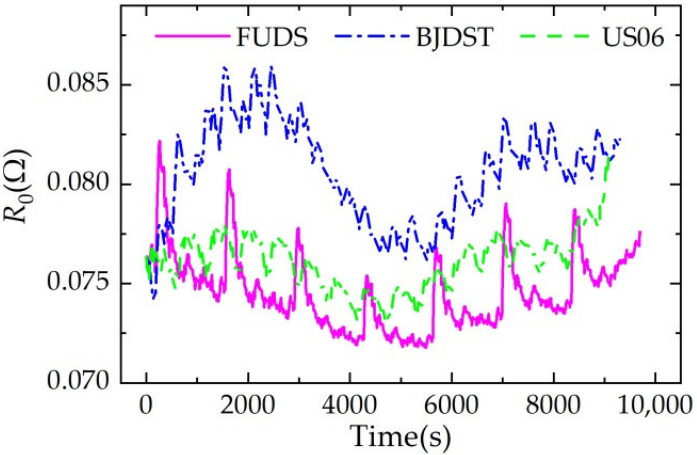
Figure 9. Identification curves of R 0 by MIUKF-FSRCKF. Table 4. SOC error and voltage error of each algorithm under BJDST.